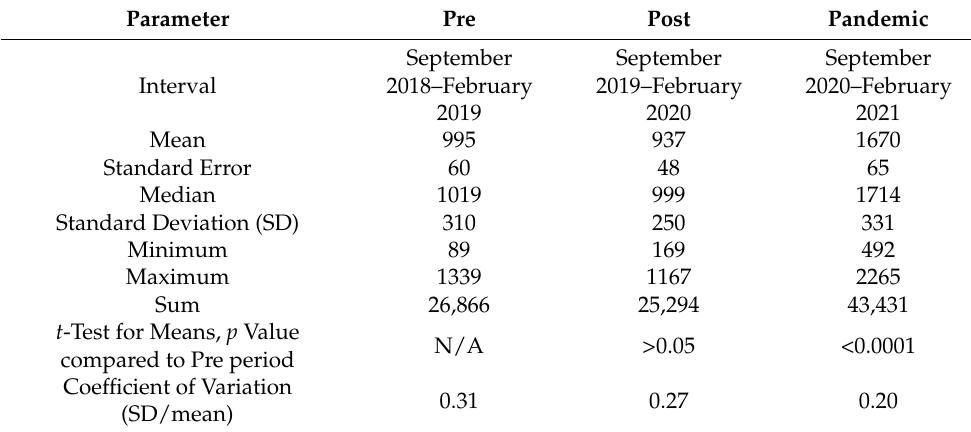
Table 2. Evaluation of Oncology Clinic Block Schedule Implementation. Weekly encounters are compared in three seasonally matched intervals surrounding implementation of the block schedule in June 2019. A new electronic medical record was also implemented in June